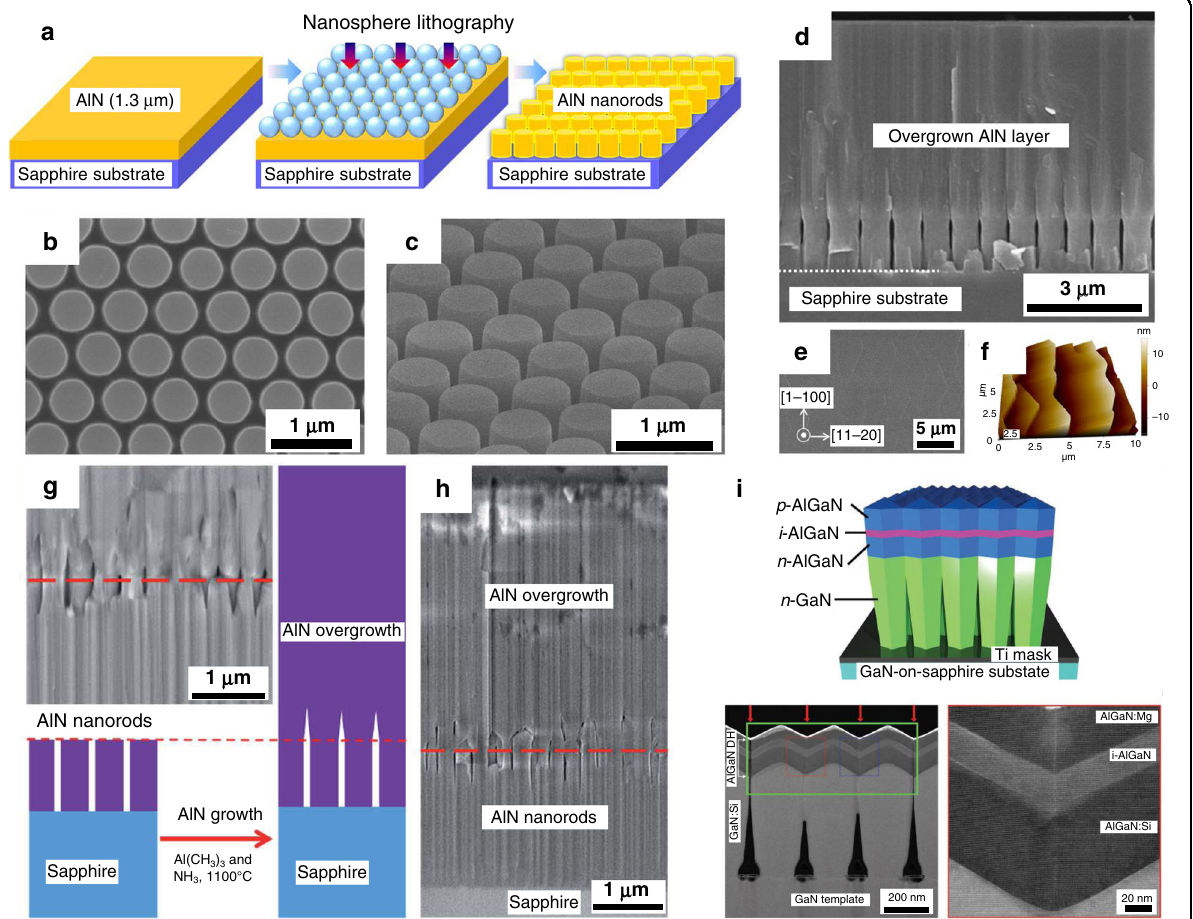
Fig. 6 Nanopatterned template for AlGaN/AlN epitaxial lateral overgrowth. a Schematic diagram of silica nanosphere lithography. b , c SEM images of the nano-patterned substrate (NPS). d Cross-section and e plane-view SEM images of the ELO-AlN layer on the NPS. f AFM image shows the macro-steps on the AlN surface. Reprinted with permission from Donghyun et al. 119 . Copyright 2017 American Institute of Physics. g SEM cross- sectional image of ELO-AlN nanorod pattern with air gaps. h SEM image of ELO-AlN on sapphire. Reprinted with permission from Conroy et al. 121 . Copyright 2015 The Royal Society of Chemistry. i Coalesced AlGaN nanowire double heterostructure LED, the following two images are cross- sectional STM-HAADF image and high-magni fi cation image, respectively. Reprinted with permission from Binh et al. 122 . Copyright 2016 WILEY-VCH Verlag GmbH & Co. KGaA,